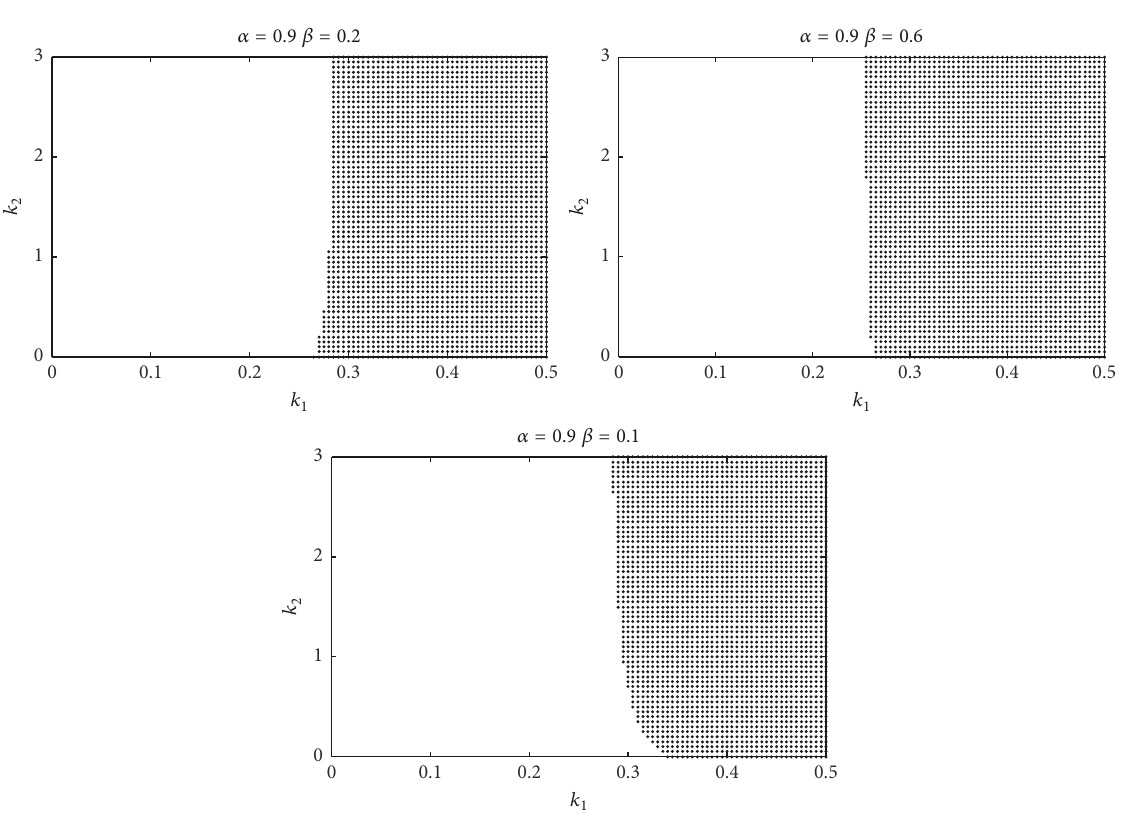
Figure 7: Stability regions in the (𝑘 1 ,𝑘 2 ) -plane for different levels of 𝛽